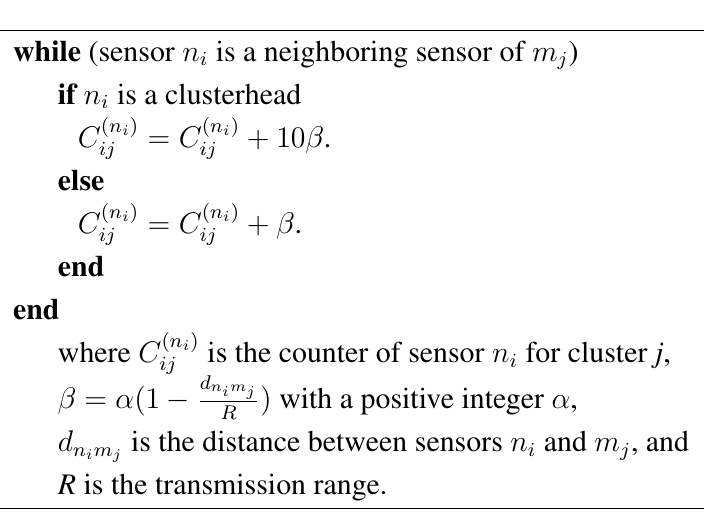
Table 2. Description of the Counter Initialization Process.